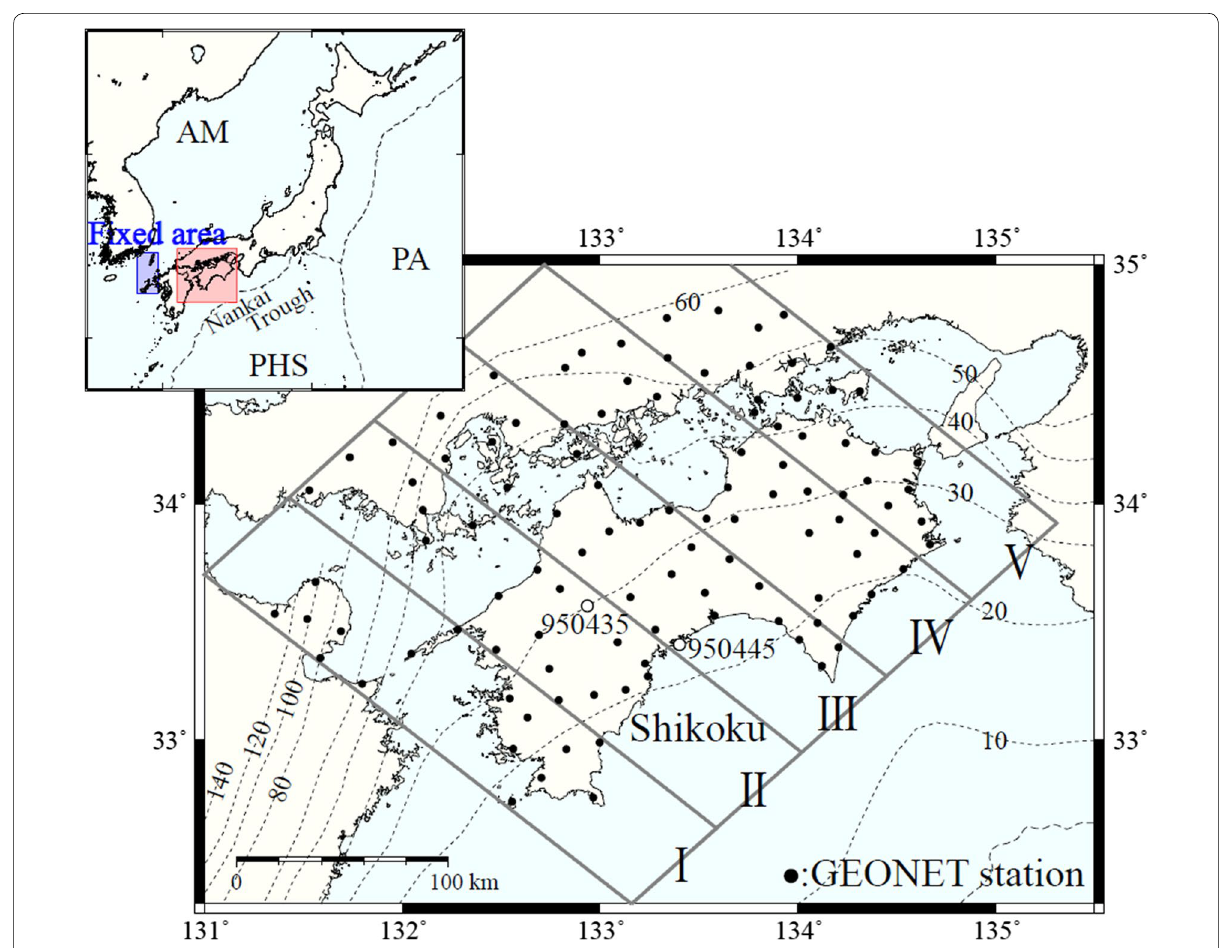
Fig. 1 Distribution of GNSS stations used in this study. Black circles indicate GEONET stations and open circles indicate GEONET stations 950435 and 950445 whose GNSS time series are plotted in Fig. 2. Black dashed contours show the iso-depth of the plate interface between the Philippine Sea and Amurian Plates (Baba et al. 2002; Nakajima and Hasegawa 2007; Hirose et al. 2008). Gray rectangles indicate the boundaries of five segments. (Inset) Tectonic map around the Japanese Islands. PA, PHS, and AM denote the Pacific, Philippine Sea, and Amurian Plates, respectively. Red and blue rectangles indicate the analysis area in this study and the area where the six reference GNSS stations are located,